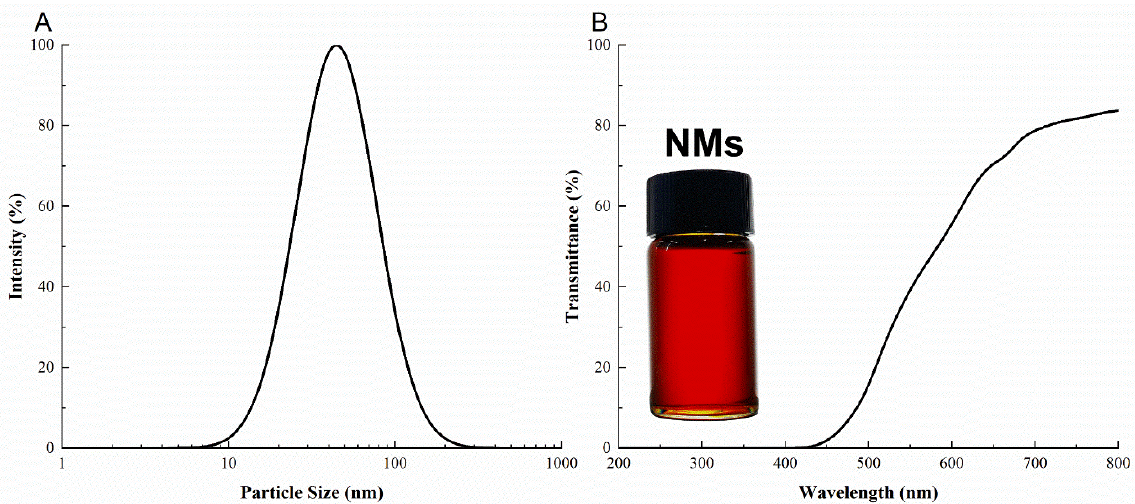
Figure 1. Particle size and light transmittance of NMs. ( A ) particle size distribution, ( B ) light transmittance. Each data represents means ± SD ( n = 5).